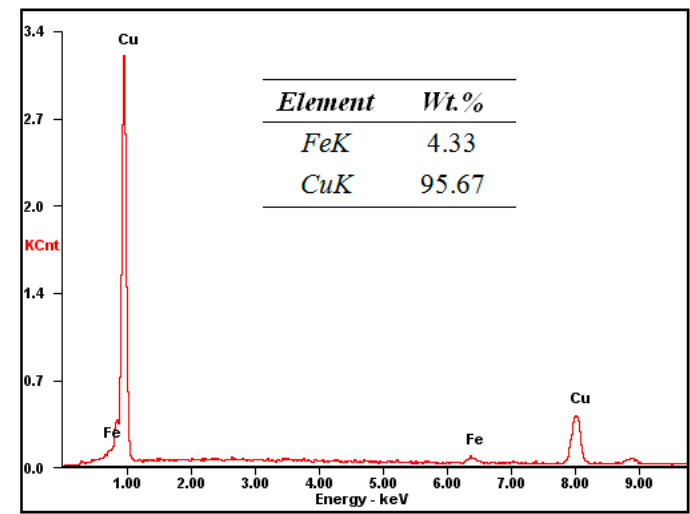
Figure 4. EDS analysis of the Cu–14Fe alloy.